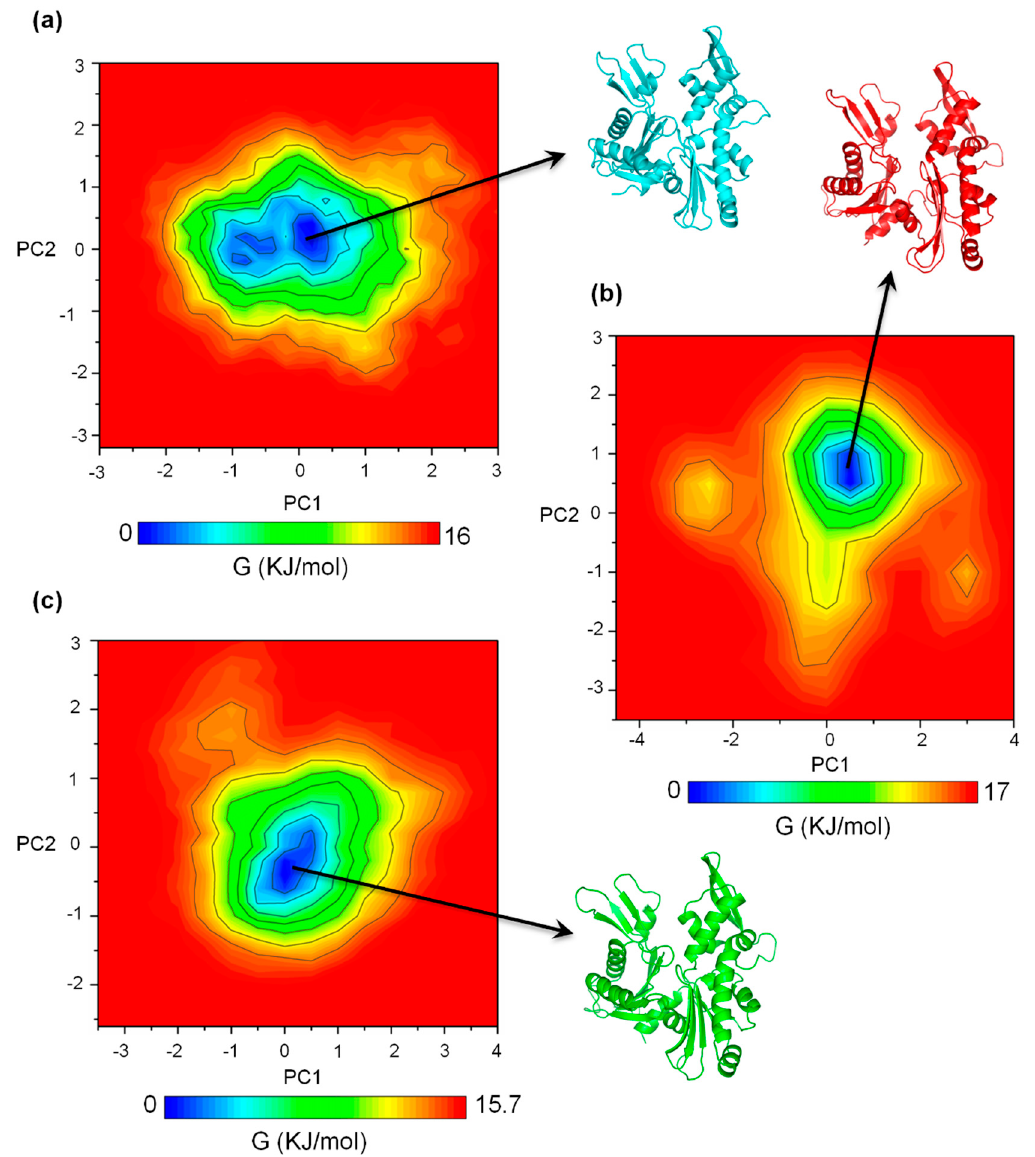
Figure 3. Free energy landscape (FEL) diagrams of the apo, ATP+ and ATP-A22+ MreB. ( a ) FEL diagram of the apo MreB. ( b ) FEL diagram of the ATP+ MreB. ( c ) FEL diagram of the ATP-A22+ MreB. The representative structures were extracted from the low energy regions colored in deep blue.